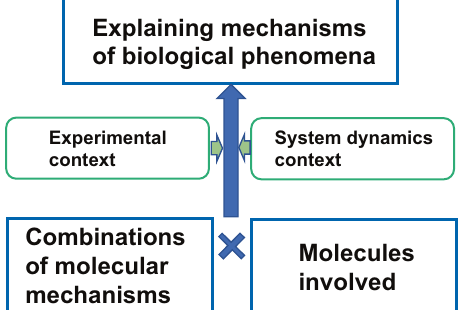
Fig. 3 A basic structure of discovery in biology. Most discoveries in biology and medicine are concerned with the identi fi cation of mechanisms behind important biological processes. It can be fundamental processes such as cell cycle and cellular reprogram- ming or clinically relevant processes such as mechanisms of disease outbreak and progression. In many cases, this basic structure will be nested into multiple levels. It should be noted that “ Molecular mechanisms ” are biological processes by themselves, thus multi- layer construction of this basic structure of discovery are